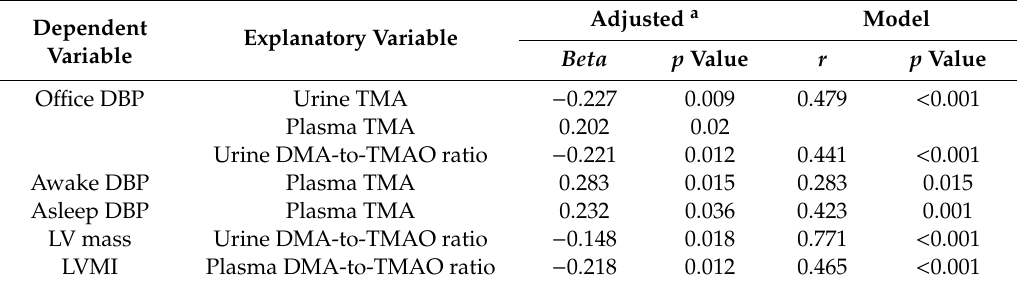
Figure 1. Correlation of plasma ( A ) DMA, ( B ) TMA, and ( C ) TMAO levels (ng / mL) with estimated glomerular filtration rate (eGFR) (ml / min / 1.73m 2 ) by Spearman’s correlation coe ffi cient. DMA = dimethylamine; TMA = trimethylamine; TMAO = trimethylamine N-oxide. Table 5. Adjusted regression model estimates of the association between plasma and urinary methylamines and cardiovascular risk factors in children with CKD stage